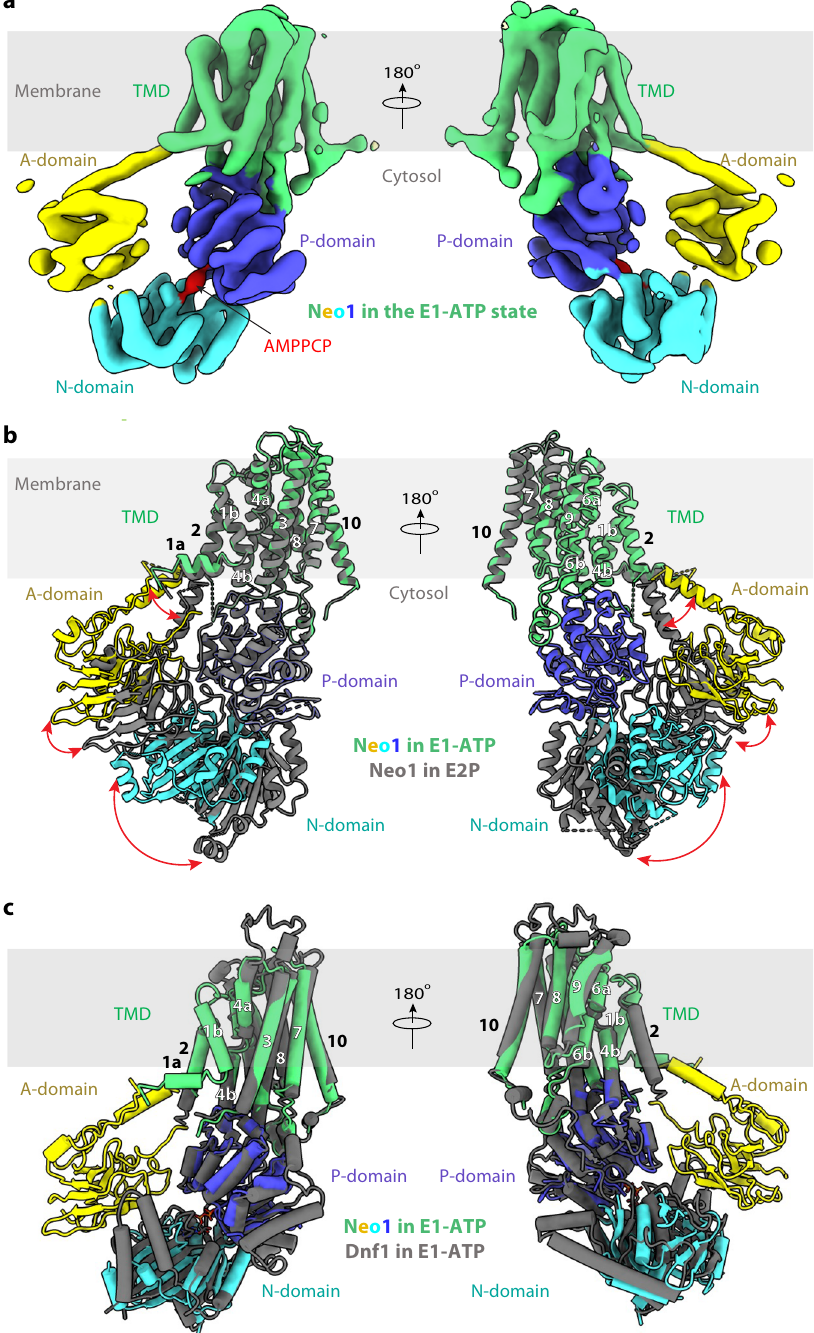
Fig. 2 Structure of the S. cerevisiae Neo1 in the E1-ATP state. a Cryo-EM 3D map of Neo1 in the E1-ATP, in the back (left) and front (right) views. The major domains are labeled in different colors. The AMPPCP density is red. b Structural comparison between Neo1 in the E1-ATP state (colors) and in the E2P state (gray) by aligning their respective TMDs. c Comparison of Neo1 (colors) and Dnf1 (gray) in the E1-ATP state by aligning their respective TMDs. The A domain of Dnf1 in the E1-ATP state is disordered and not